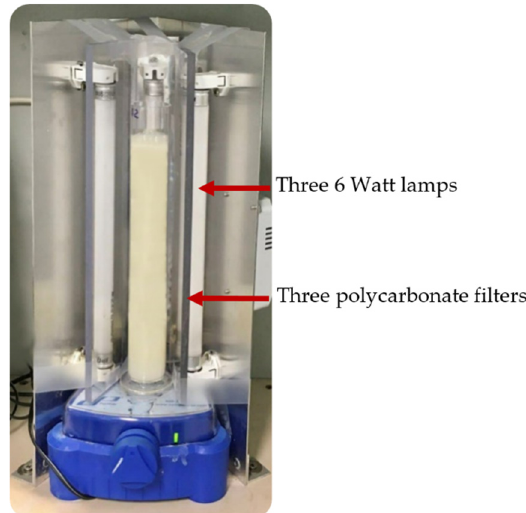
Figure 1. A photograph of the photoreactor setup for the photocatalytic oxidation of the 2,4-DCP.